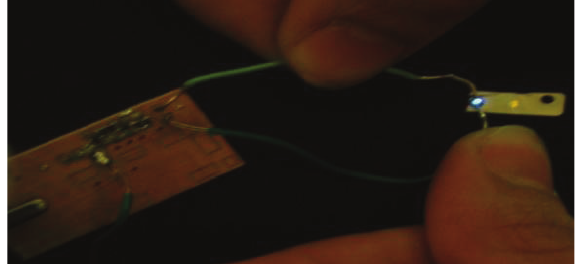
Figure 15: A LED, empowered by the proposed harvester.